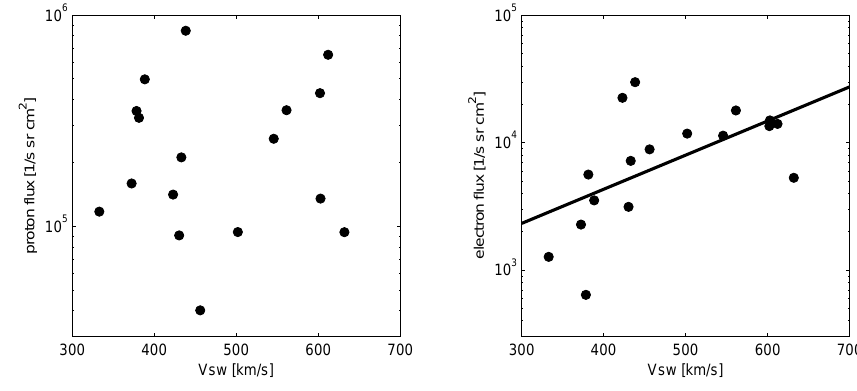
Fig. 12. Energetic particle fluxes in the HLPS as a function of solar wind speed. Left: protons, right: